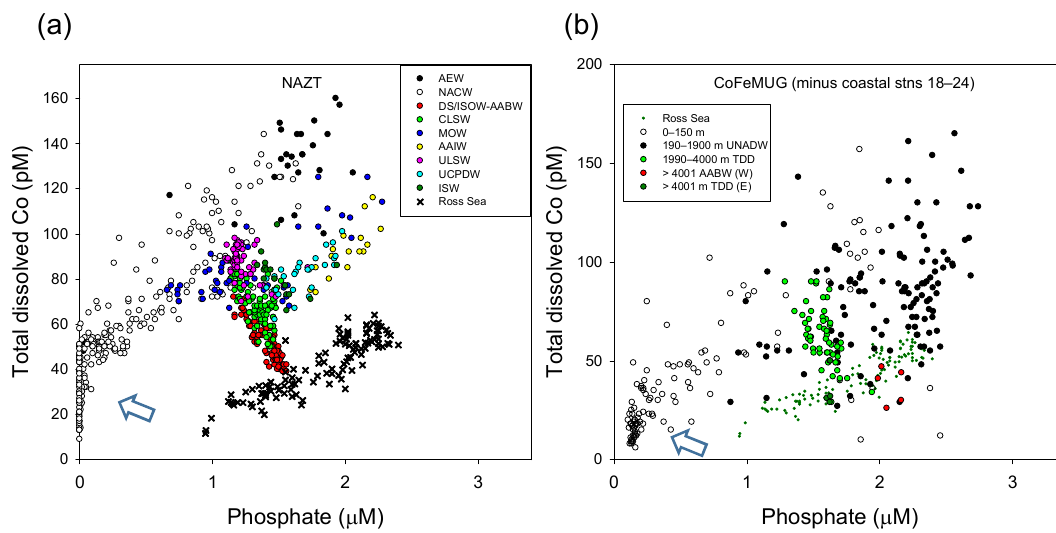
Figure 2. Total dissolved cobalt versus phosphate distributions observed across different regions in the North (GA03/3_e) and South Atlantic (GAc01; a and b , respectively). Water masses were identified by OMPA analysis (optimum multiparameter water mass analysis; DSOW – Denmark Strait Overflow Water; ISOW – Iceland Scotland Overflow Water; CLSW – classical Labrador Sea Water; MOW – Mediterranean Overflow Water; ULSW – Upper Labrador Sea Water; UCDW – Upper Circumpolar Deep Water; AAIW – Antarctic Intermediate Water; ISW – Irminger Sea Water; Jenkins et al., 2015, their Table 1). In the South Atlantic water masses correspond broadly to water masses as described in Saito et al. (2012), where UNADW<2000m (Upper North Atlantic Deep Water), AABW>4000 in the western basin, and TDD (two-degree discontinuity) was the major contributor to both 2000–4000 and >4000m in the eastern basin of the South Atlantic. Ross Sea dissolved cobalt data are included from Saito et al. (2010), representing a Southern Ocean endmember. Blue arrows indicate areas with steep dCo:P